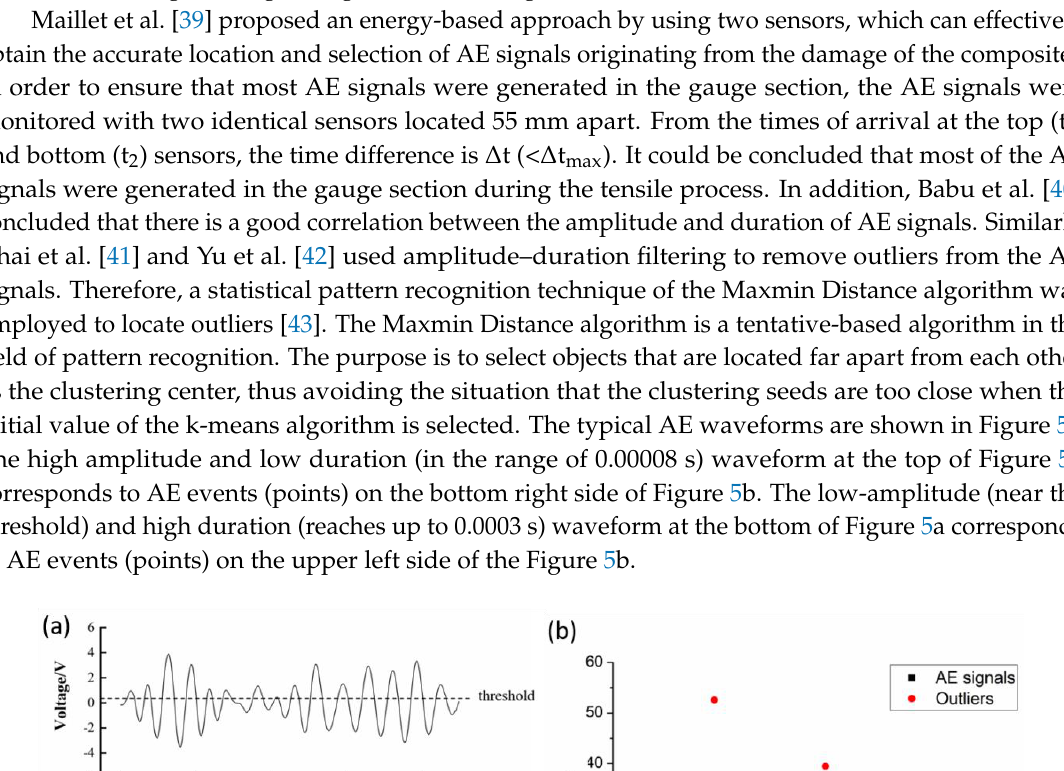
Figure 6. The tensile loading curve versus displacement for the composite specimen. Table 2. Summary of measured mechanical properties and corresponding AE characteristics. Material